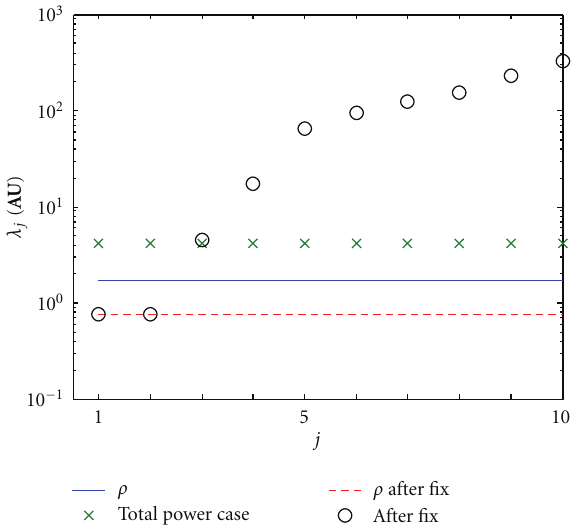
Figure 2: λ j ( AU ) as a function of j (the index of eigenvalues) when the fix is used